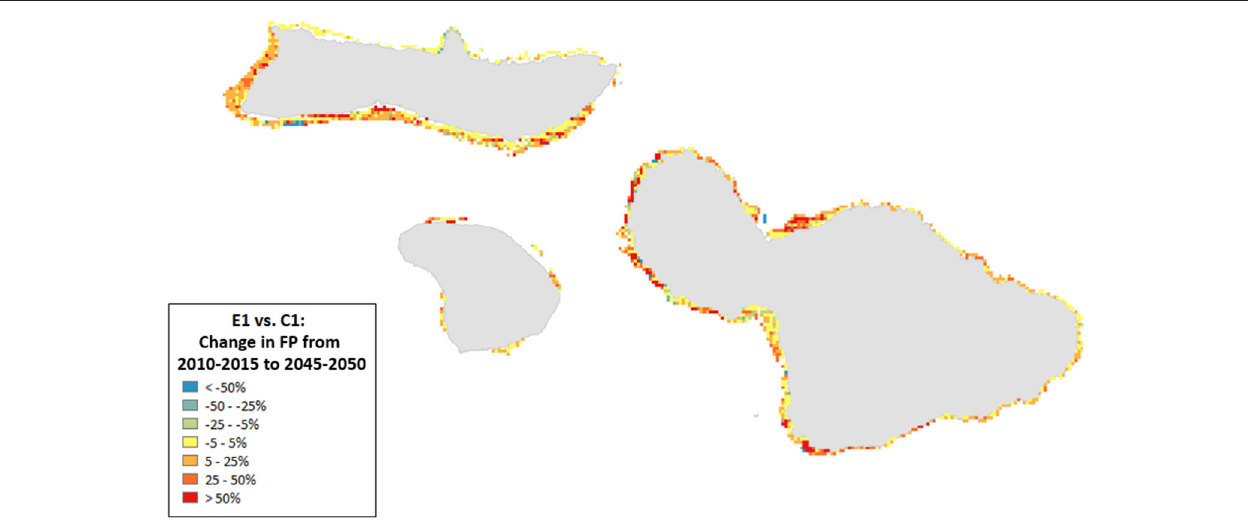
FIGURE 10 | Ratio of change in Fisheries Production (2010–2050) for scenario E1 (high sediment mitigation, 30% MPAs) compared to C1 (Current Management) under severe climate-related stressors. A value of 0 indicates no change from the outcome in 2050 under Current Management, values > 0 indicate an improvement (or, more accurately, less of a decline from the Current Management), while values < 0 indicate a worsening of the decline relative to Current